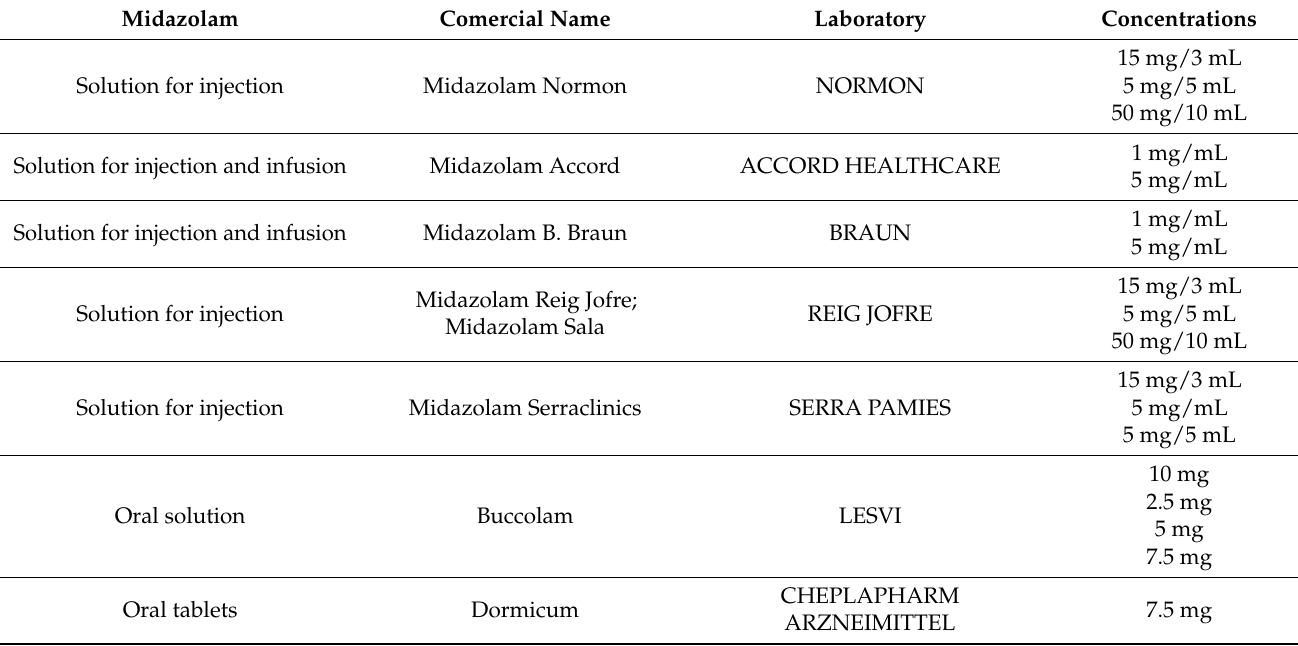
Table A1. Midazolam marketed in Spain, 2021